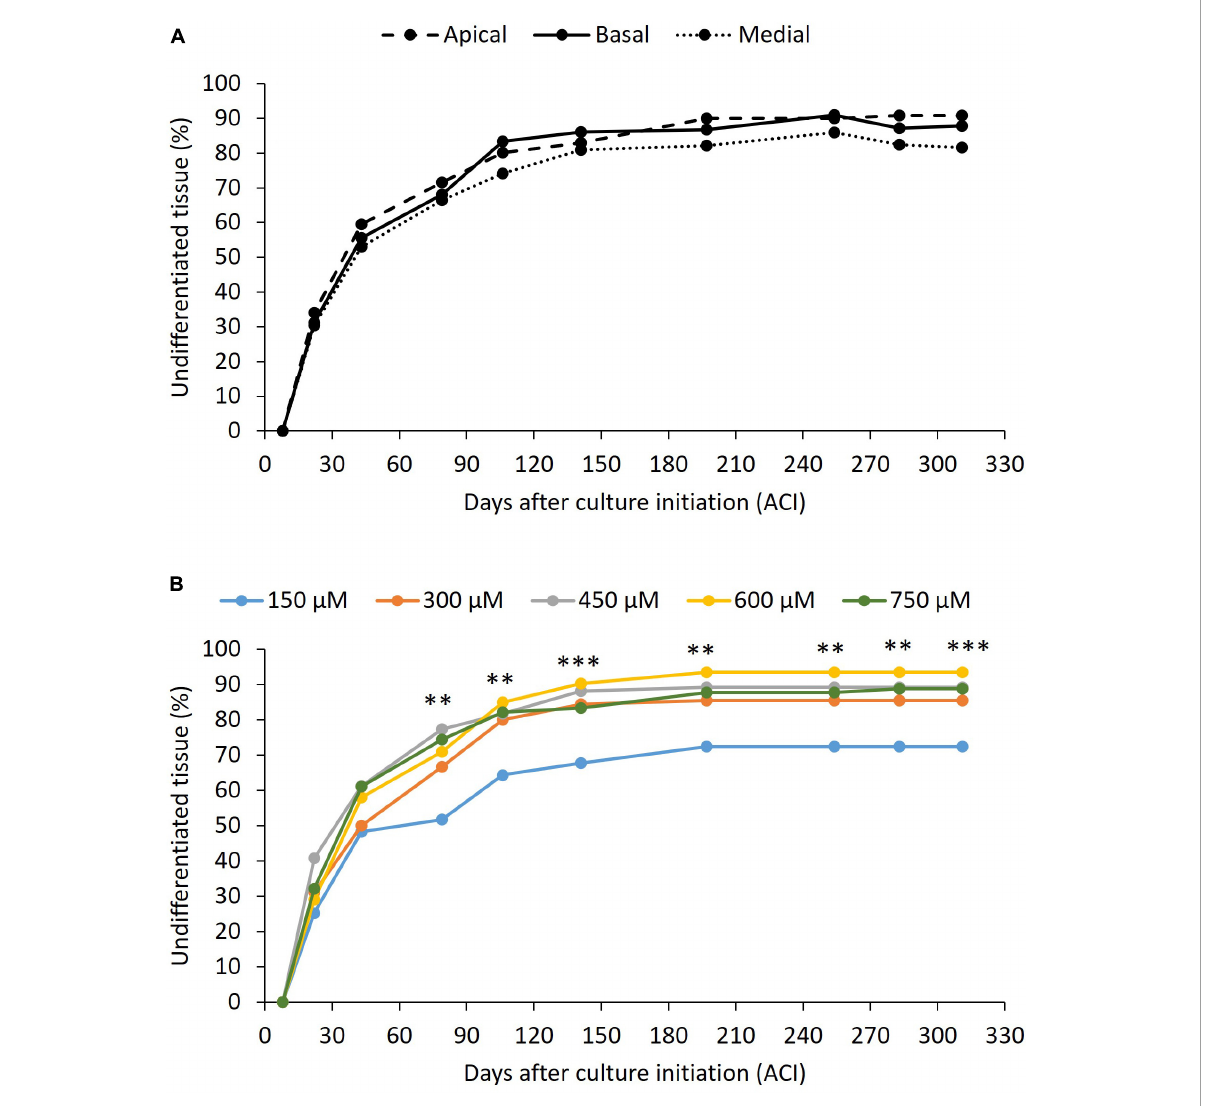
FIGURE4 Effect of the peach palm TCLs position (A) and picloram concentration (B) on undifferentiated tissue formation. p -value less than 0.01 ( ∗∗ ) and less than 0.001 ( ∗∗∗ ), according to Tukey’s test at 95% confidence level. Exact p -values and differences among treatments can be found in Supplementary material . At least nine replicates per treatment were